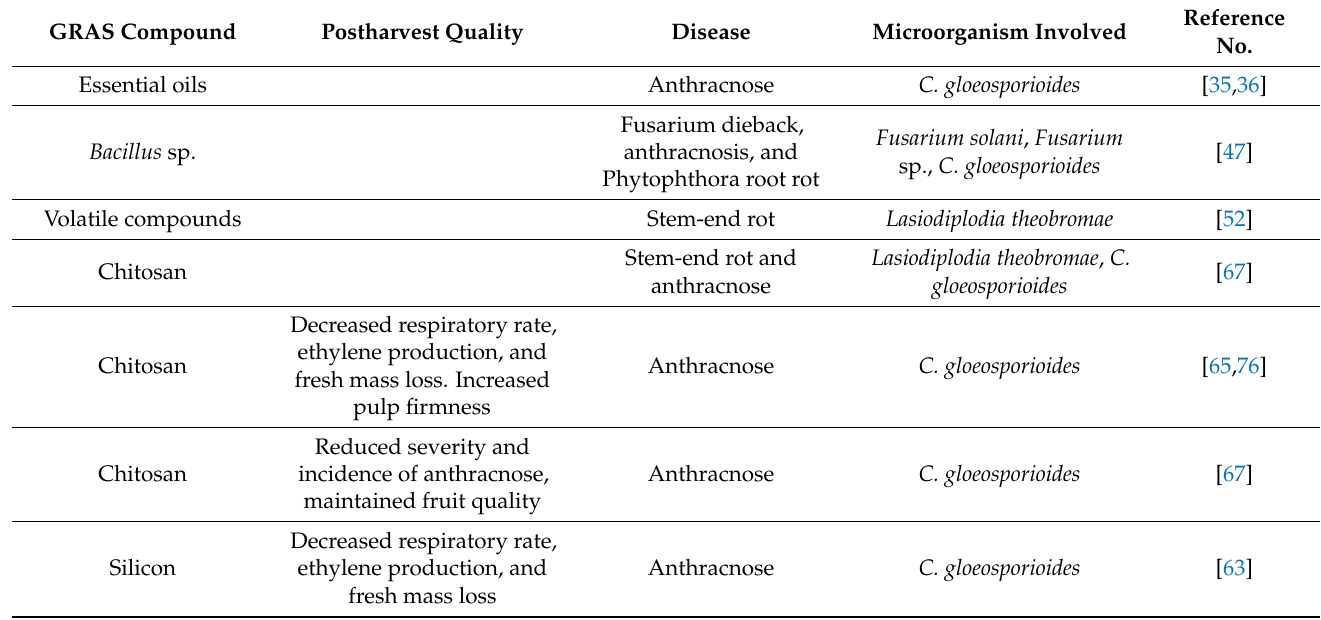
Table 2. Main effects of GRAS application on avocado postharvest quality, disease, and pathogens involved during storage. GRAS Compound